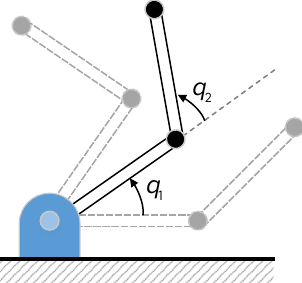
Figure 2. The studied two-link manipulator for simulation. The initial and end configurations for robot movement are in dashed